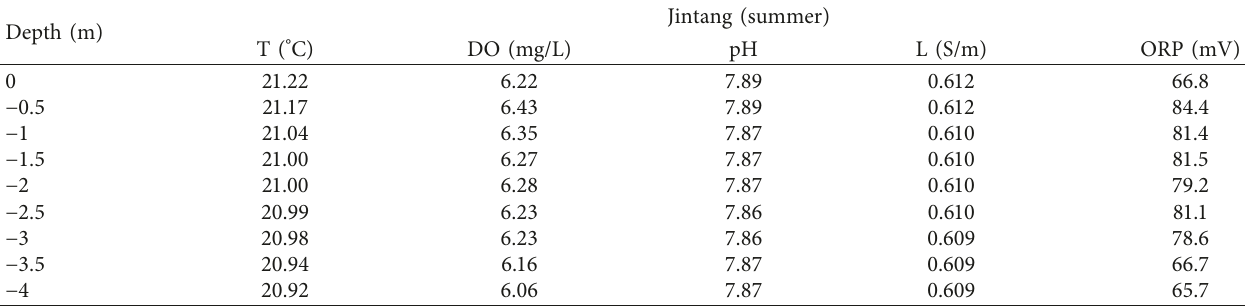
Table 1: Results on the physicochemical parameters of overlying water of Jintang in summer, Tuohe River.